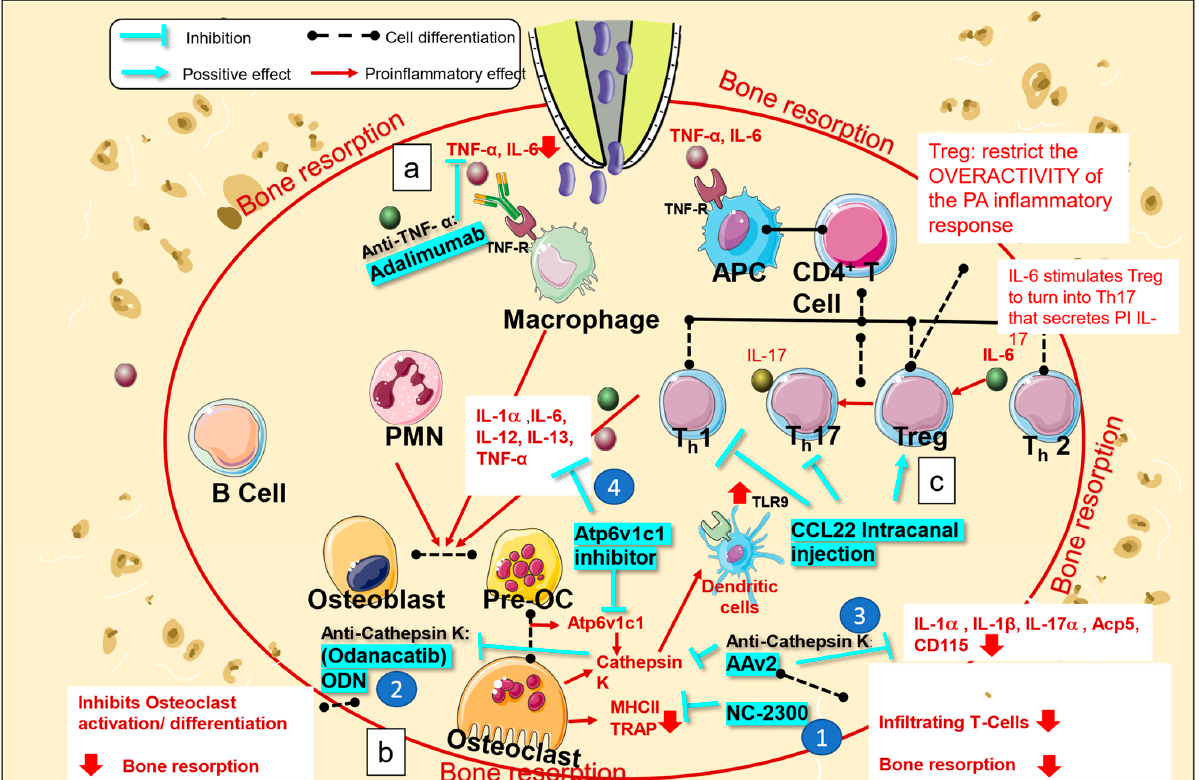
Figure 2. Mechanism of action of biological medications used for the treatment of apical periodon- titis. Bacterial invasion in the root canal stimulates periodontal cells and immunocytes to secrete proinflammatory cytokines (interleukin IL)-1, IL-6, tumor necrosis factor (TNF- α ). ( a ) Biological medications, such as anti-TNF- α monoclonal antibodies (adalimumab), block the binding of TNF- α to TNF- α receptors, subsequently decreasing TNF- α and IL-6 production. ( b-1 ) NC-2300, a cathepsin K inhibitor, inhibits the expression of TRAP and MHCII in osteoclasts. ( b-2 ) Odanacatib amelio- rates osteoclast activation and differentiation. ( b-3 ) AAv2 reduces the infiltration of T-cells and expression of osteoclasts and macrophages markers, such as Acp5, CD115, IL-1 α , IL-1 β , and IL-17a. ( b-4 ) Atp6v1c1 inhibitors reduce bone resorption by impairing osteoclast activation and downregu- lating the production of TNF- α , IL1- α , IL-13, IL-12, and IL-6. ( c ) CCL22, a chemotactic cytokine, was found to stimulate Treg migration and downregulate Th1 and Th17 expression. APC, antigen pre- senting cell; Treg, regulatory T-cell.